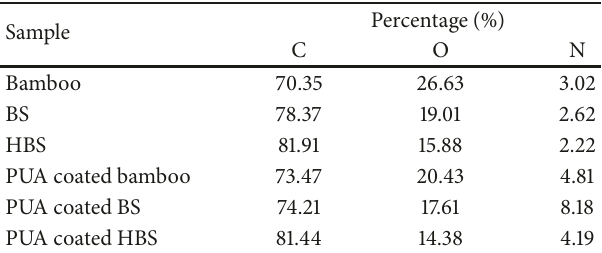
Table 2: Elements percentages of bamboo, BS, HBS, and their coated